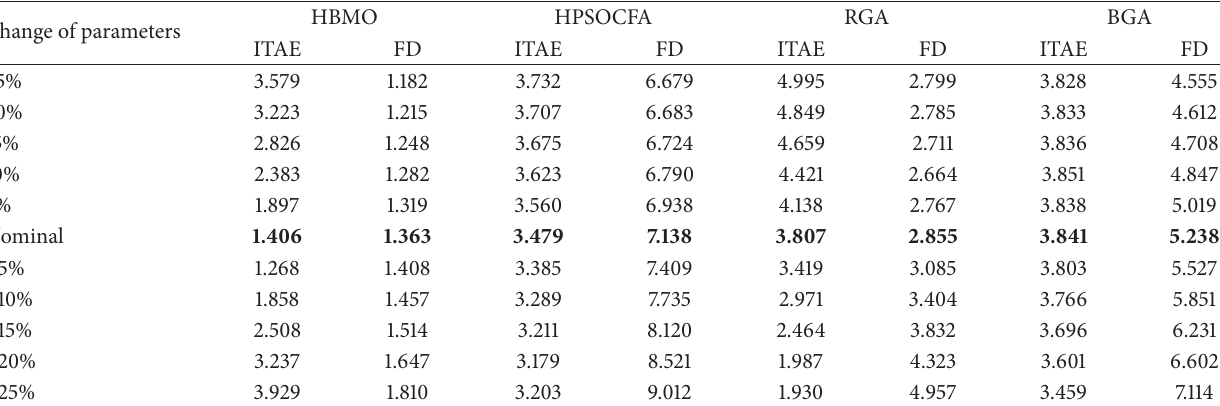
Table 6: ITAE and FD in serial number 2 for scenario I in Case 2.